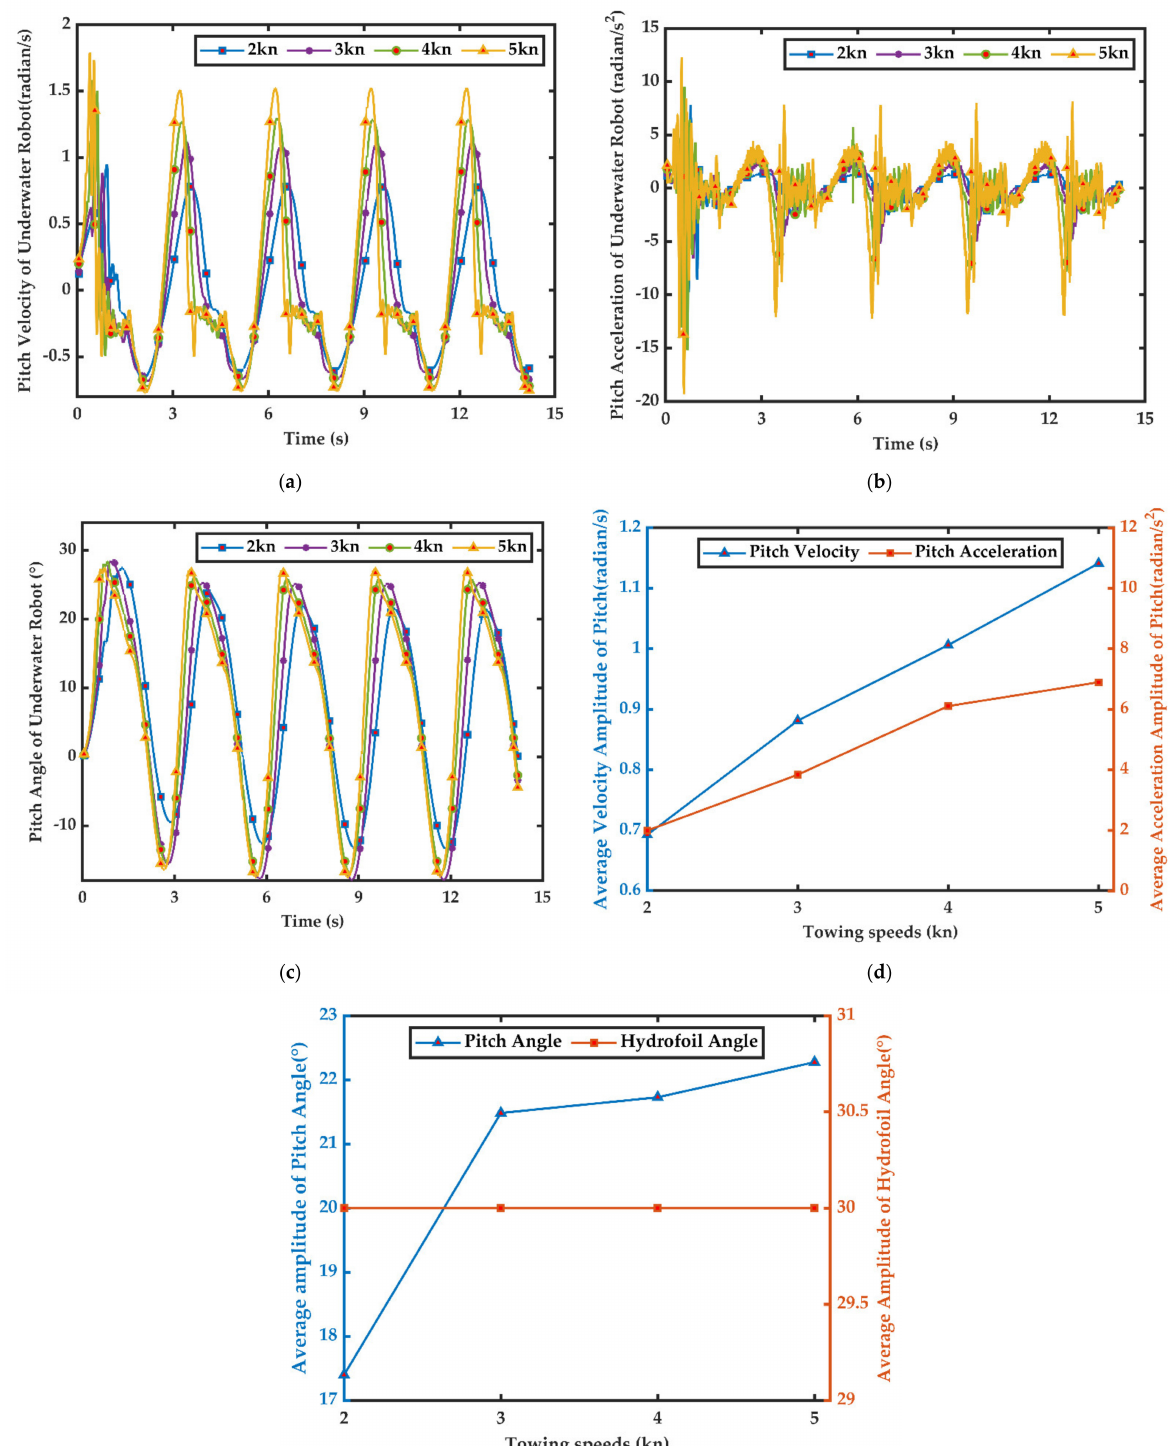
Figure 9. The time history of the pitch velocity, acceleration and angle of the tethered underwater robot at different towing speeds: ( a ) the pitch velocity of the tethered underwater robot; ( b ) the pitch acceleration of the tethered underwater robot; ( c ) the pitch angle of the tethered underwater robot; ( d ) the average amplitude of the tethered underwater robot’s pitch velocity and acceleration; ( e ) the average amplitude of the tethered underwater robot’s pitch angle and the average amplitude hydrofoil’s